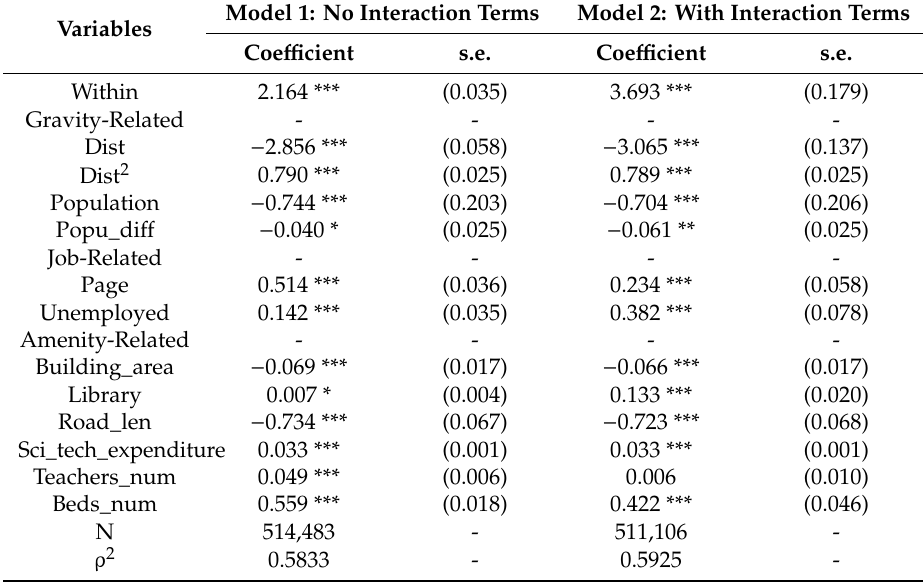
Table 3. Regression results.